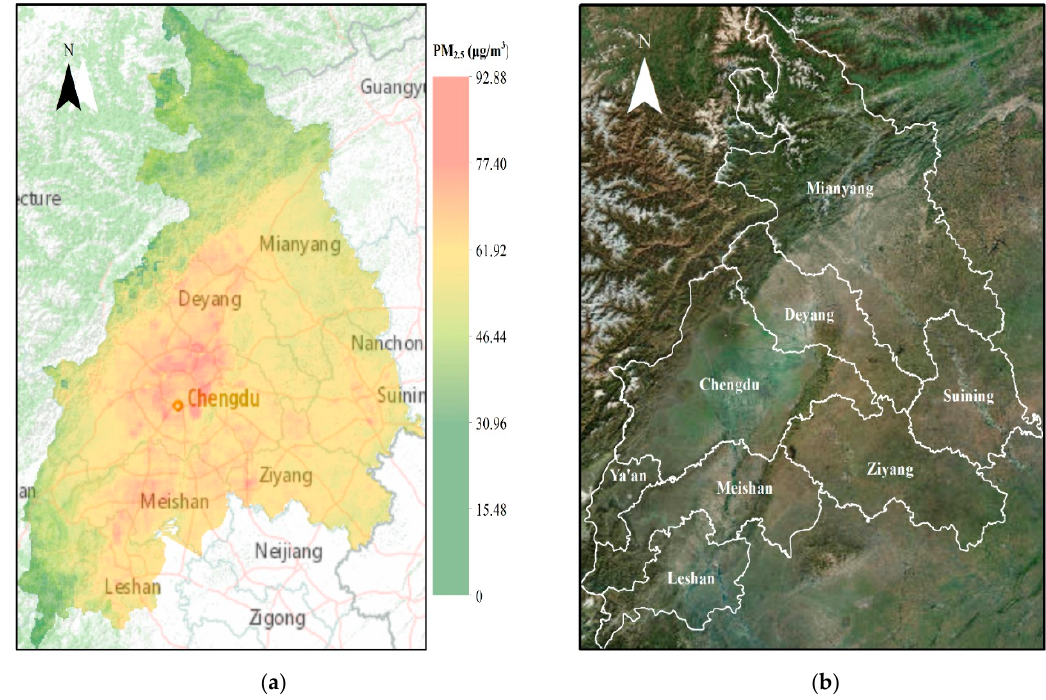
Figure 5. ( a ) Maps of mean PM 2.5 concentration ( µ g / m 3 ) averaged from all PM 2.5 estimates model valid days for 2015, and the back ground is tra ffi c map. ( b ) Satellite imagery map for Chengdu Plain (Satellite imagery source: Esri, DigitalGlobe,